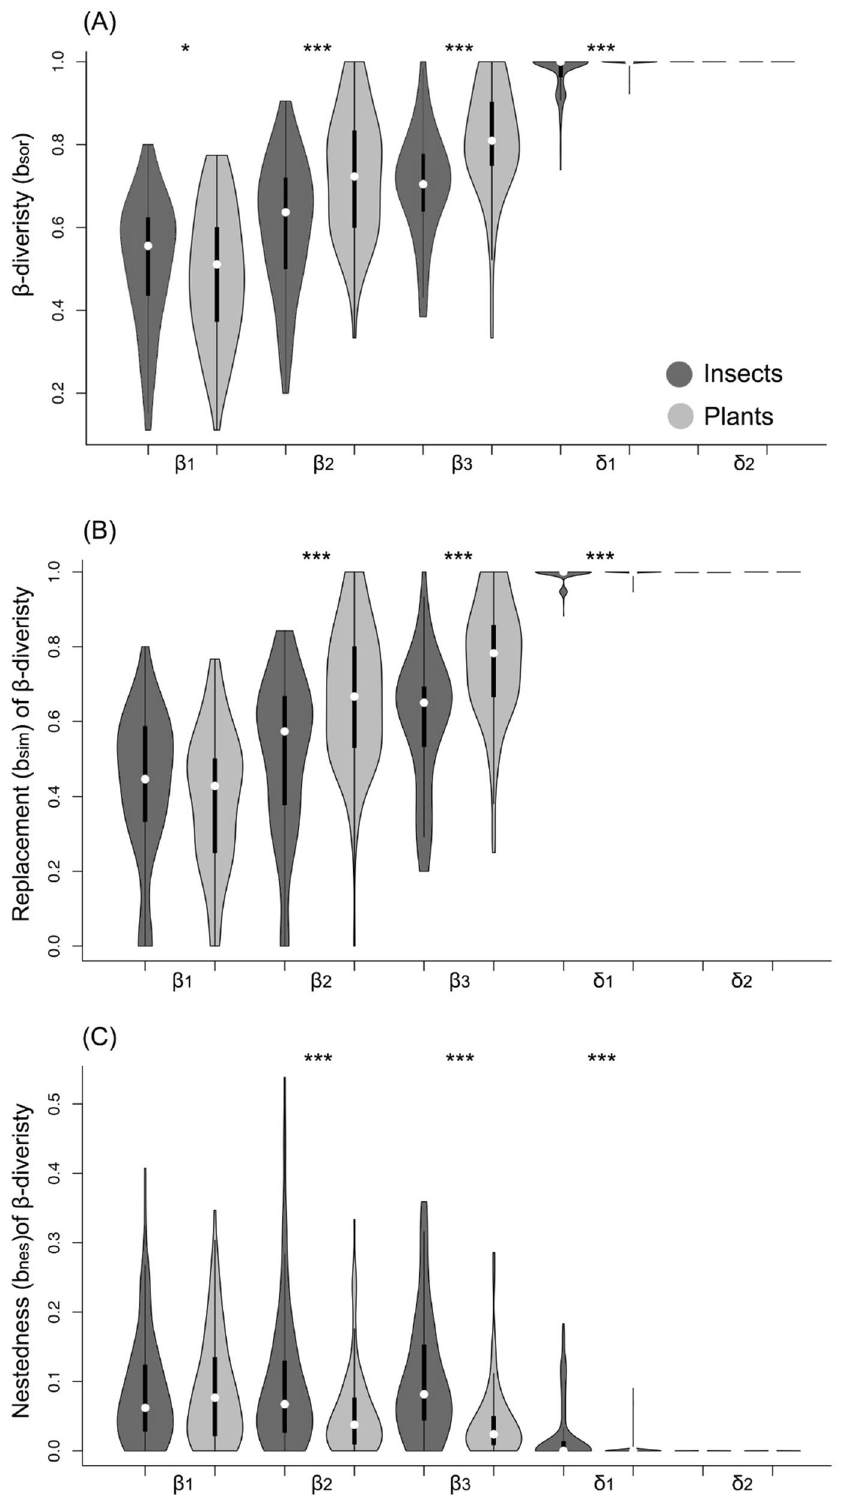
Figure 1. Insect species (dark grey) and plant species’ (light grey) bsor (overall beta diversity), bnes (nestedness component of bsor), and bsim (replacement component of bsor) was calculated between the survey plots (25 × 20 m 2 ) at different spatial distances: (1) plots within transects (β 1 : 40–100 m scale), (2) plots between two neighboring transects within a region (β 2 : 200– 300 m scale), (3) plots between two transects covering the highest elevation gradient within a region (β 3 : 1–3 km scale), (4) plots between two neighboring regions (δ 1 : 250–300 km scale), and (5) plots between two regions covering the highest spatial distance (δ 2 : > 500 km scale). White dots represent medians, thick black bars represent first quartiles and thin black lines represent the range. The shape of each plot shows the frequency distribution of the data. *, ** and ***Significant differences in β-diversity between insects and plants at each spatial scale and region (significance codes: *** P < 0.001, ** P < 0.01, * P <